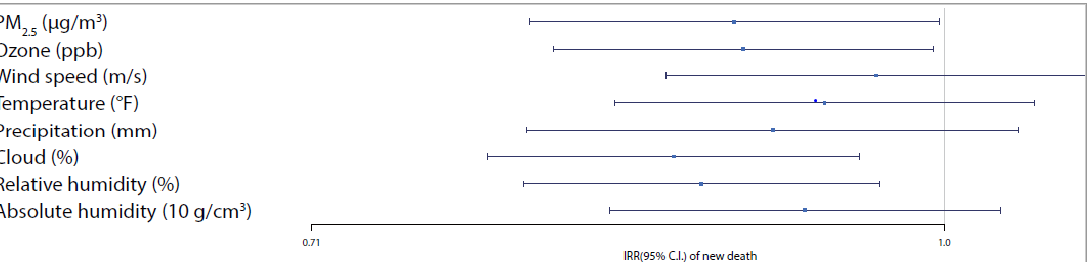
Figure 5. Trend and lag-case adjusted IRRs (and 95% CIs) associated with each environmental predictors for new COVID-19 confirmed cases.